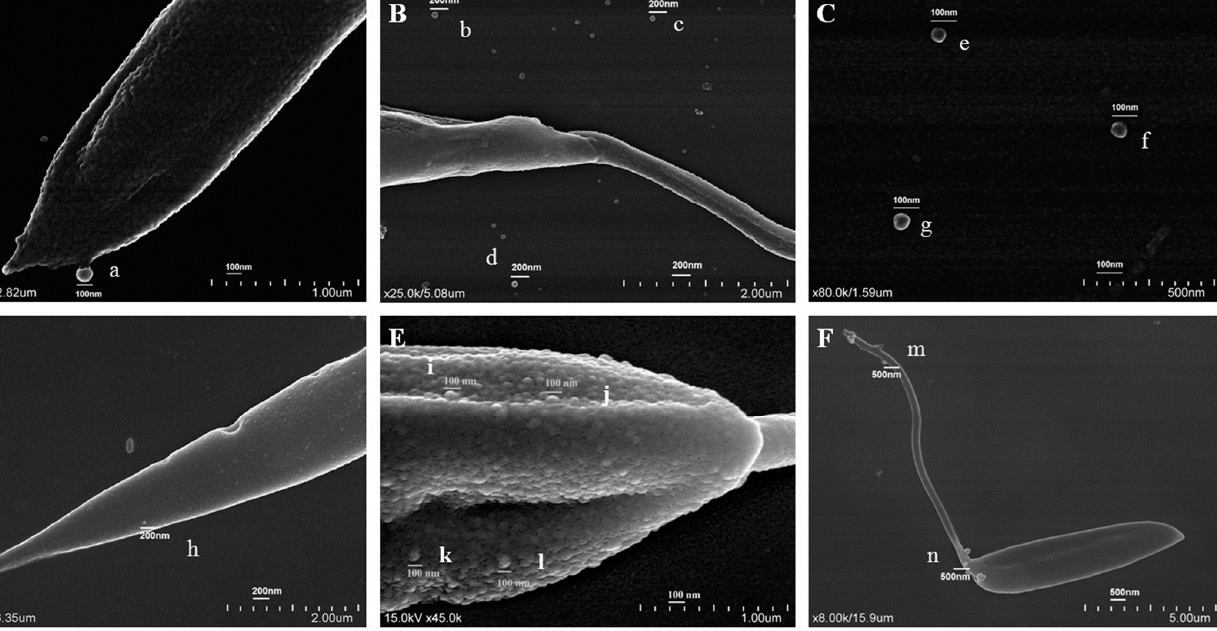
Figure 1. Topography of promastigotes and EVs of L. shawi and L. guyanensis . Scanning electron microscopy of cultured L. shawi ( A–C ) and L. guyanensis ( D–F ) promastigotes exhibiting protrusions compatible with EVs biogenesis ( A,D–F ). Free EVs ( B,C ) with less than 100 nm can also be